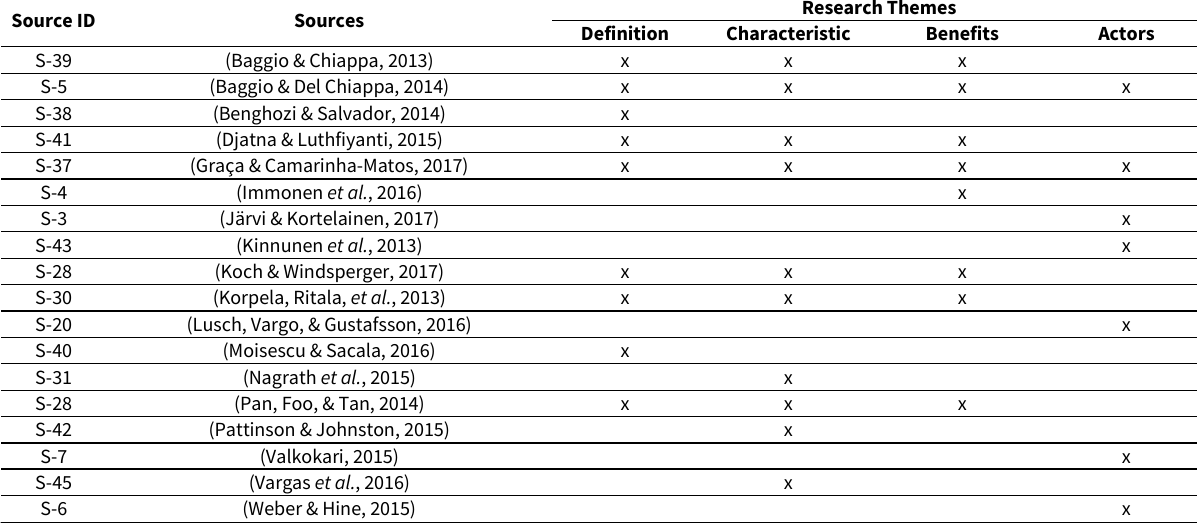
Table 6. Key concepts of